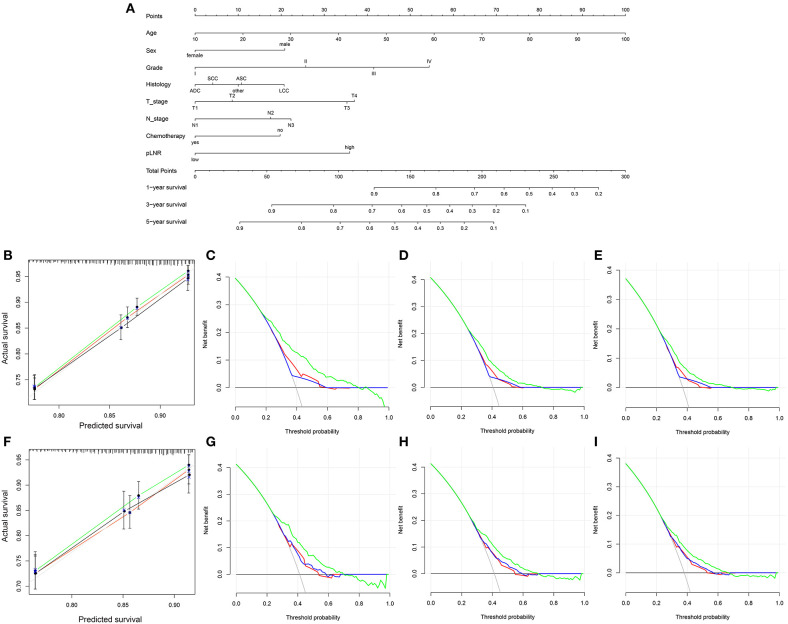
(A) Nomogram used to predict the 1-, 3- and 5-year OS rates of patients with T1−4N1−3M0 NSCLC. (B) Calibration curve of the nomogram for predicting the 1-, 3- and 5-year OS rates of patients with T1−4N1−3M0 NSCLC from the training set. Decision curve analysis of the AJCC 7th stage, nomogram and positive lymph node ratio (pLNR) for the 1- (C), 3- (D) and 5-year (E) OS rates of patients with T1−4N1−3M0 NSCLC from the training set. (F) Calibration curve of the nomogram for predicting the 1-, 3- and 5-year OS rates of patients with T1−4N1−3M0 NSCLC from the validation set. Decision curve analysis of the AJCC 7th stage, nomogram and pLNR for the 1- (G), 3- (H) and 5-year (I) OS rates of patients with T1−4N1−3M0 NSCLC from the validation set. OS, overall survival; pLNR, positive lymph node ratio; NSCLC, non-small cell lung cancer. For calibration curves, green, red, and black line represent 1, 3, and 5 years, respectively. For decision curve analysis, green represents the nomogram, red represents pLNR, and blue represents AJCC 7th stage.